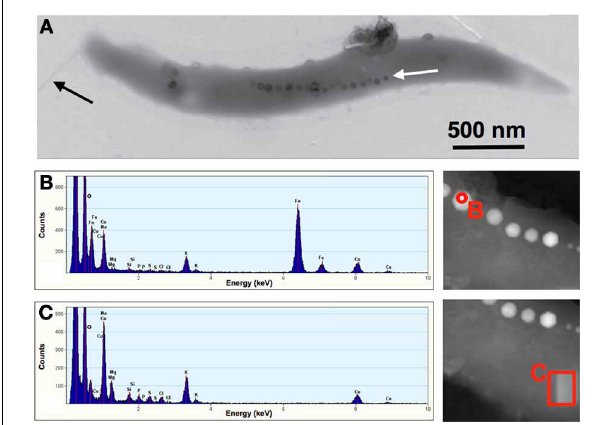
FIGURE 3 | Spirillum-shaped magnetotactic bacterium from Pavilion Lake, British Columbia, Canada (A). The cells averaged 2.9 μ m long and 0.3 μ m wide with a single chain of magnetosomes (white arrow) and a single flagellum (black arrow). Scale bar is 500nm. The mineral crystals averaged 47 × 44nm. The nanocrystal marked with a red circle was selected for EDX spectra shown in (B) , which shows that the crystals were made of iron and oxygen (copper peak was due to the support grid). The part of the bacterial cell marked with a red rectangle was selected for the EDX spectra shown in (C) , which allowed us to identify the background elements that were present in the cellular matrix.